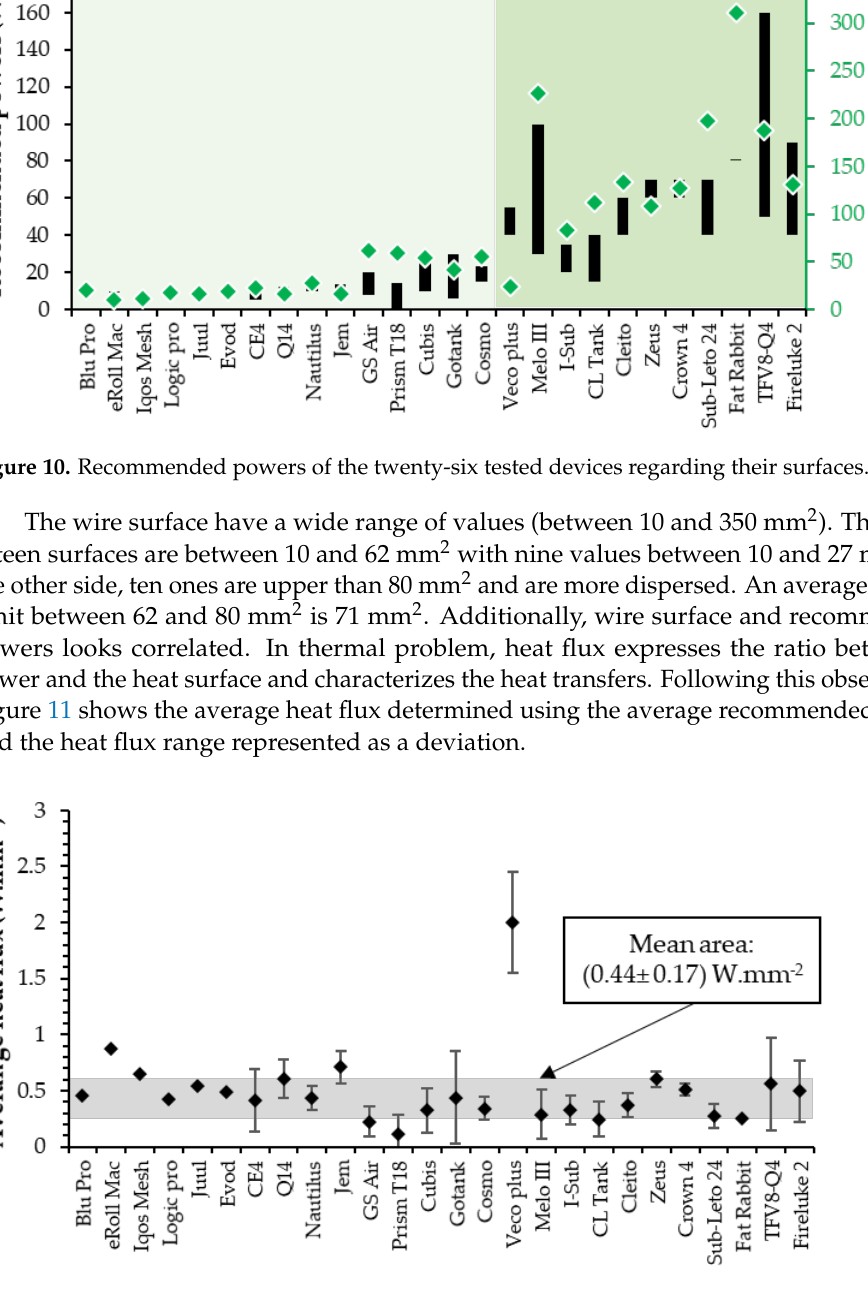
Figure 11. Average heat flux of the twenty-six tested devices. Except for the Veco plus, the average heat flux presents an interesting dispersion that is around (0.44 ± 0.17) W mm −2 . This might represents a pleasant limit of the generated aerosol. Veco plus is a device with a notable element of design that is not present in the others: its wire is melded into a ceramic element. Its complete immersion might allow a higher heat flux comparing with partially immerged wire.